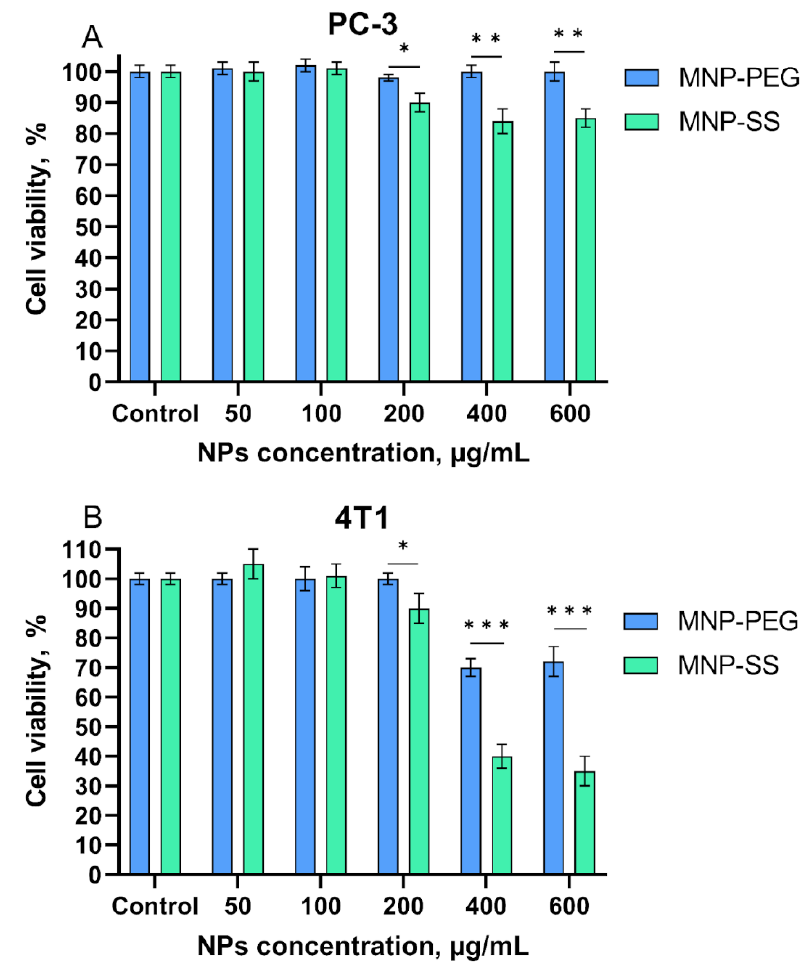
Figure 6. Evaluation of cytotoxicity of MNP-PEG and MNP-SS on PC-3 ( A ) and 4T1 ( B ) cells. Differences were considered statistically significant at: *— p < 0.05, **— p < 0.01, ***— p < 0.001.